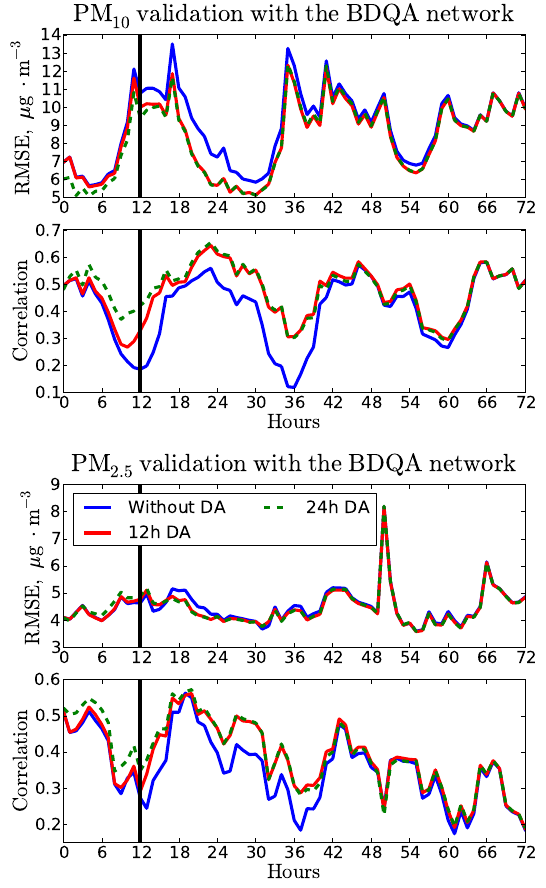
Figure 7. The top (or bottom) panel shows the time evolution of the RMSE (µgm − 3 ) and the correlation of PM 10 (or PM 2 . 5 ) aver- aged over the different DA experiments for three experiment types: one without DA, one with 12h of DA and one with 24h of DA. The scores are computed for the BDQA network (hourly data). The vertical black lines denote the separation between the assimilation period (to the left of the black lines) and the forecast (to the right of the black lines). “12 DA” (“24 DA”) stands for DA with 12 (24) hours of analysis. The forecasts of “12 DA” and “24 DA” start at the same moment. The scores in the first 12 analysis hours of “24 DA” are not shown.